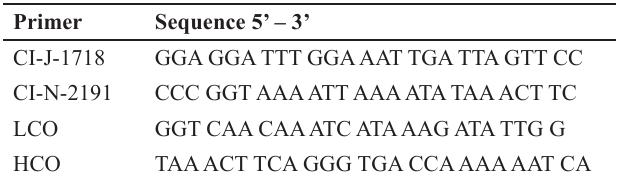
Table 1 . Cytochrome Oxidase 1 primers used to generate DNA barcodes for the reference database.